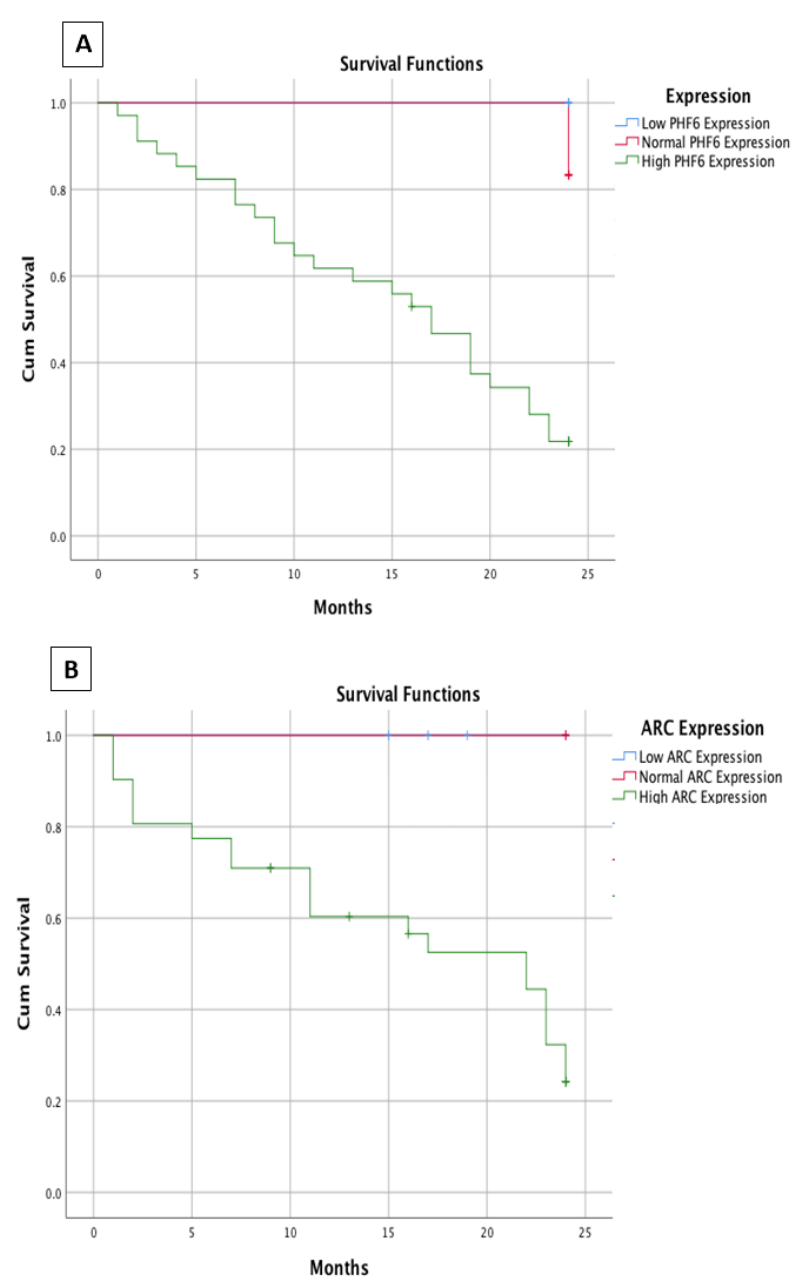
Figure 6 - Survival analysis in AML patients. Kaplan-Meier survival analysis of overall survival (A) according to PHF6 expression levels and (B) according to ARC expression levels. The Plots showed that AML patients with high PHF6 or ARC transcript levels have lower MST than patients with normal or low expression levels (log-rank P value is 0.02 and 0.026